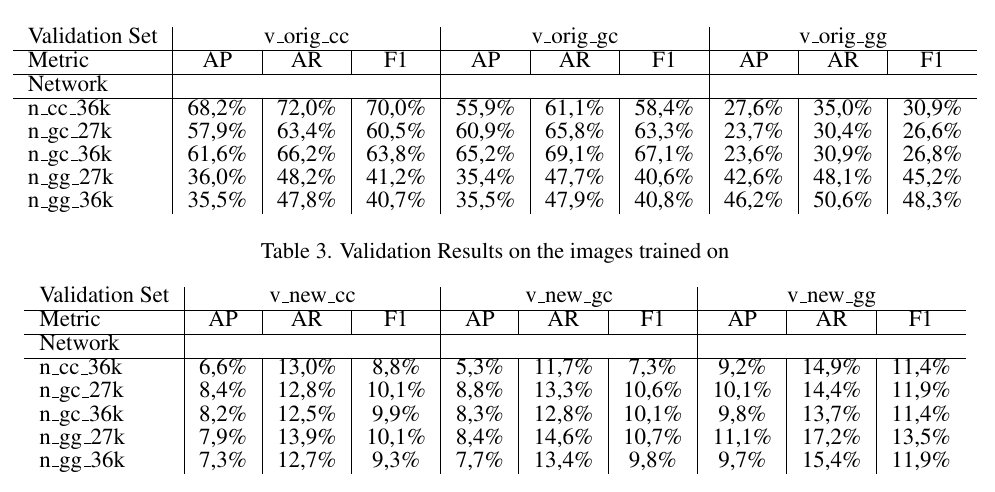
Table 4. Validation Results on unknown